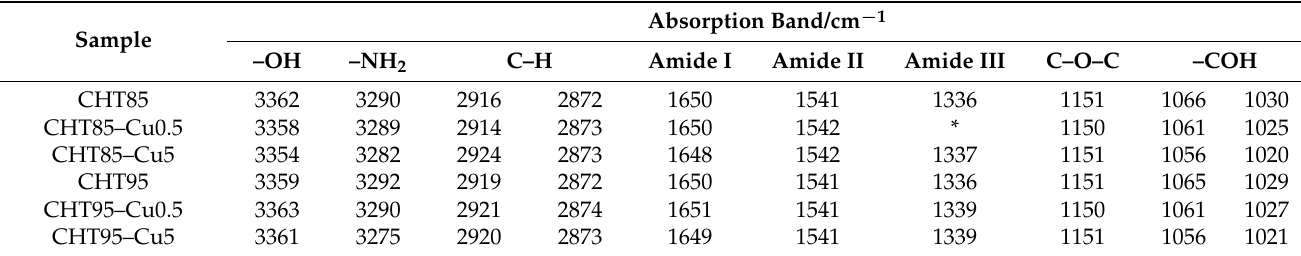
Table 2. FTIR bands characteristic for chitosan and chitosan–Cu 2+